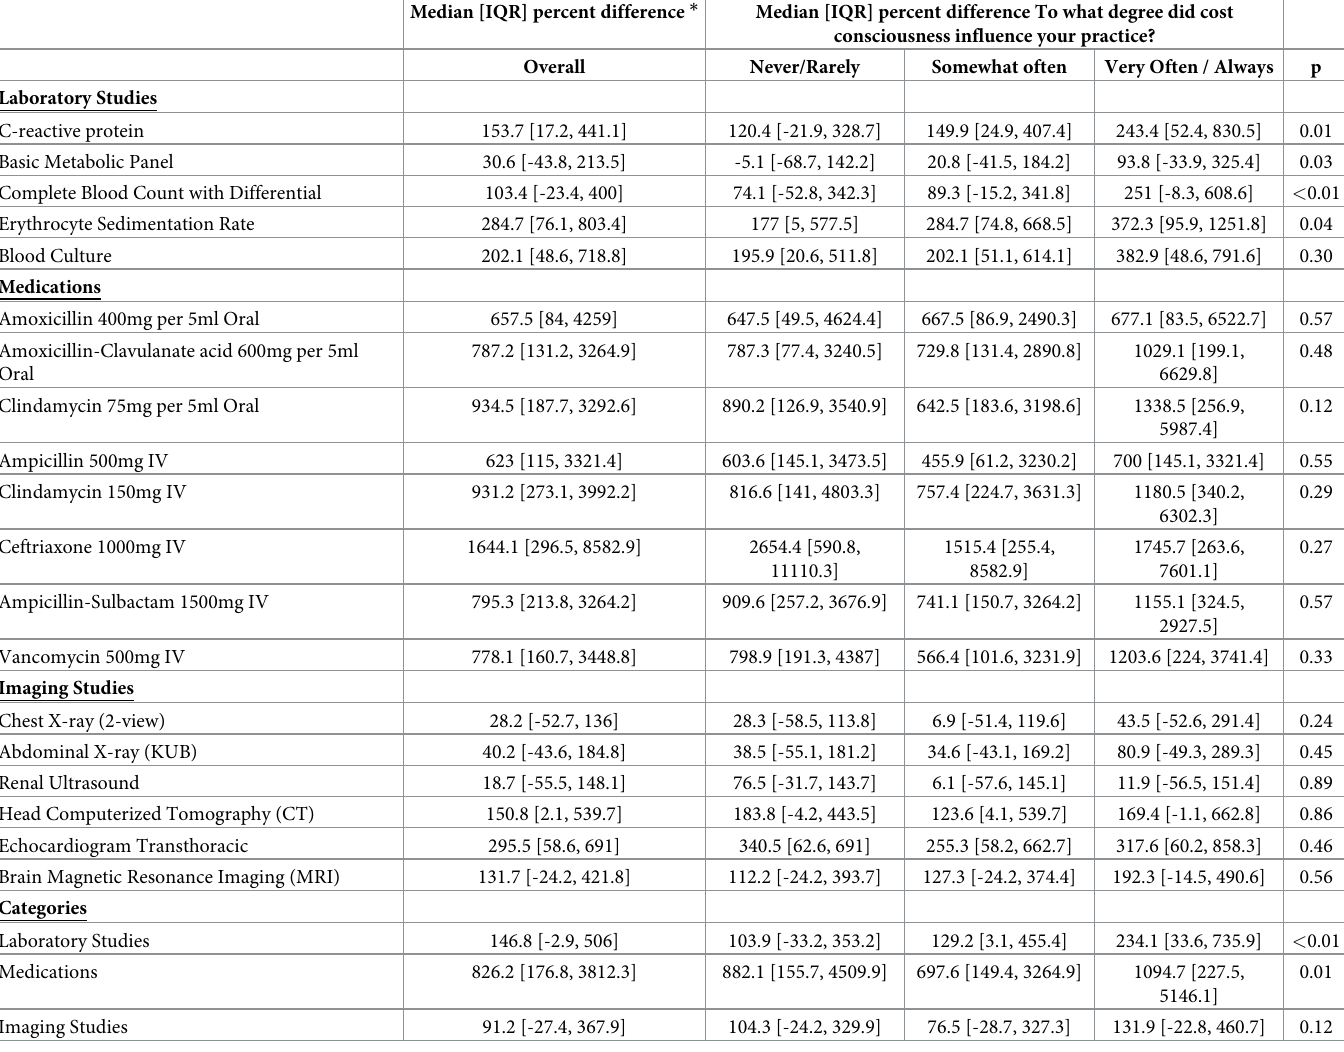
Table 5. Median [interquartile range] percent difference and self-reported cost consciousness.